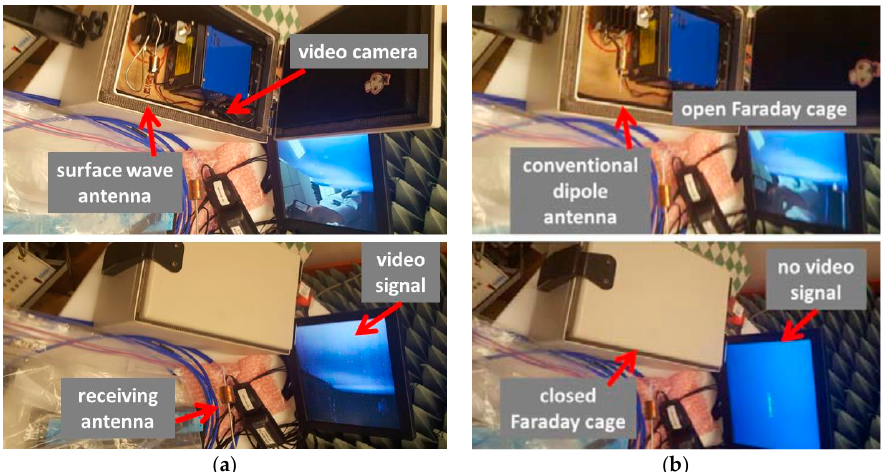
Figure 4. ( a ) SEW antenna maintains transmission of video signal from a locked − 90 dB Faraday cage (JRE Test, model 0709). ( b ) Conventional dipole antenna cannot transmit the video signal when used in the same experimental configuration.